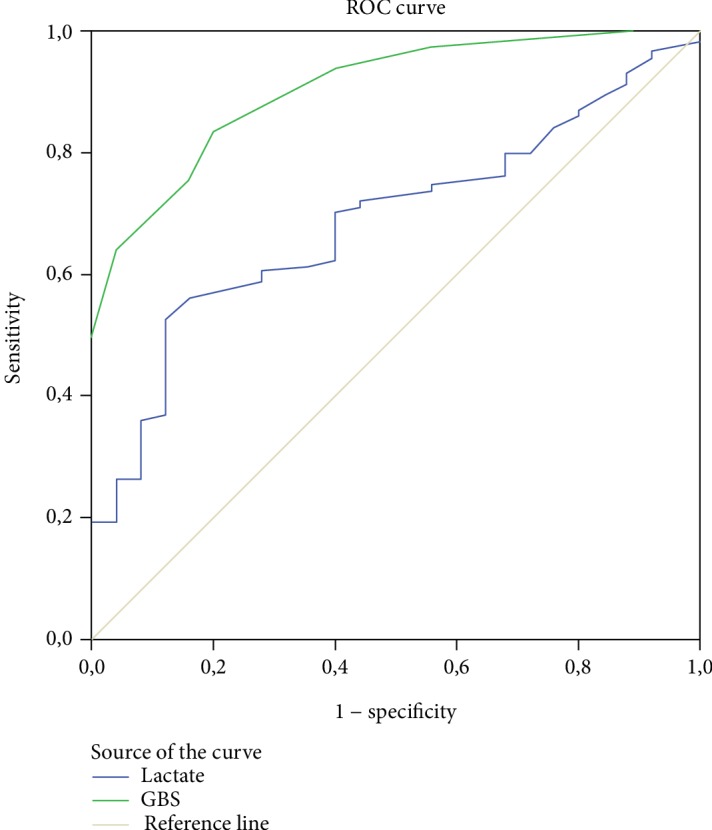
ROC curves showing comparisons of lactate and GBS in predicting need for red blood cell transfusion.